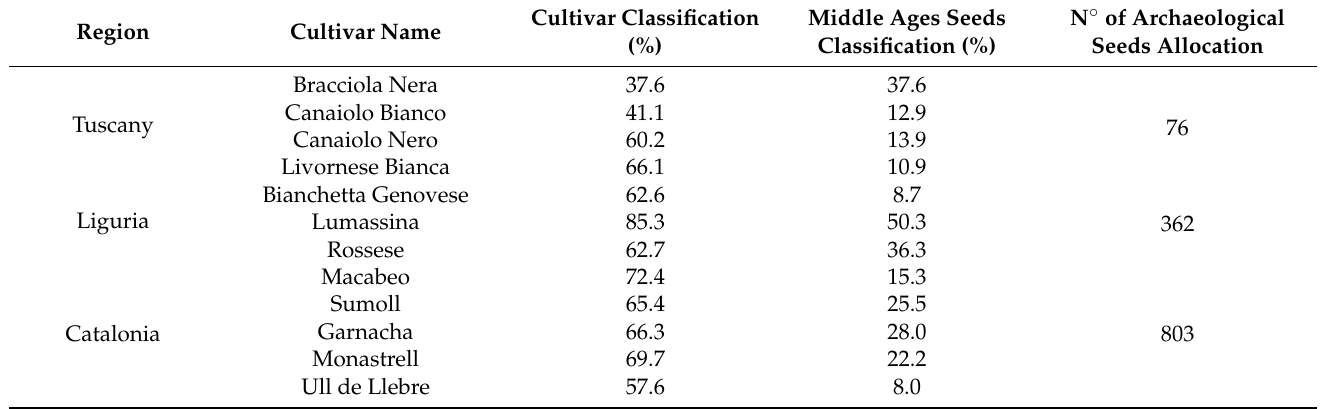
Table 5. Correct classification percentage between Vitis vinifera subsp. vinifera cultivars and Middle Ages seeds considered as